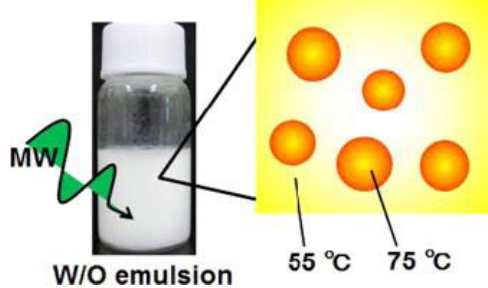
Figure 4. Selective heating of water/oil emulsion (water droplets are represented by the orange bubbles) [54].